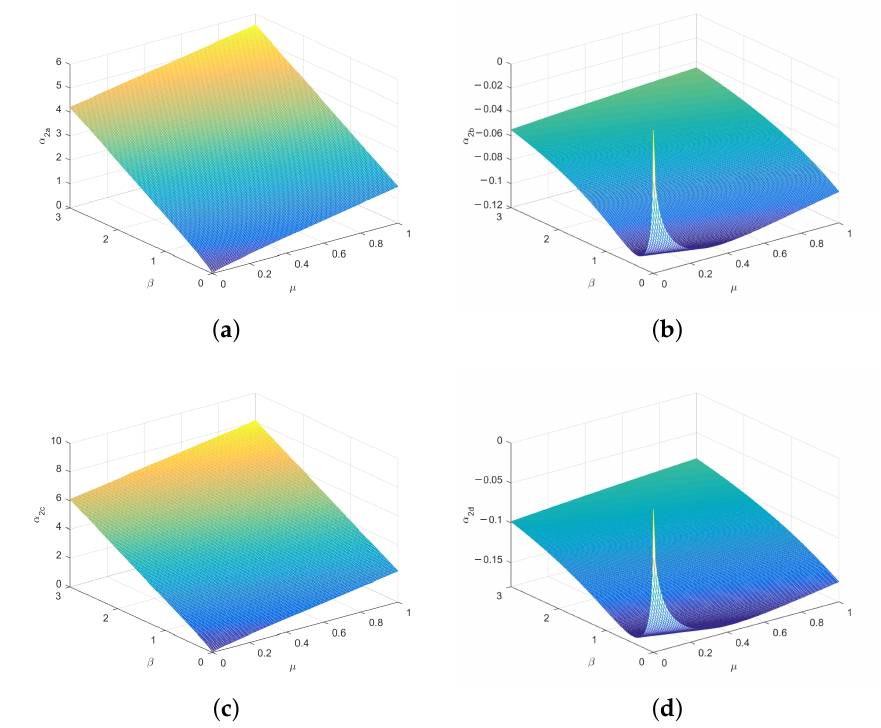
Figure 3. The relationship of ( µ , β , α 2 ) : ( a ) ( µ , β , α 2 a ) space; ( b ) ( µ , β , α 2 b ) space; ( c ) ( µ , β , α 2 c ) space; ( d ) ( µ , β , α 2 d )